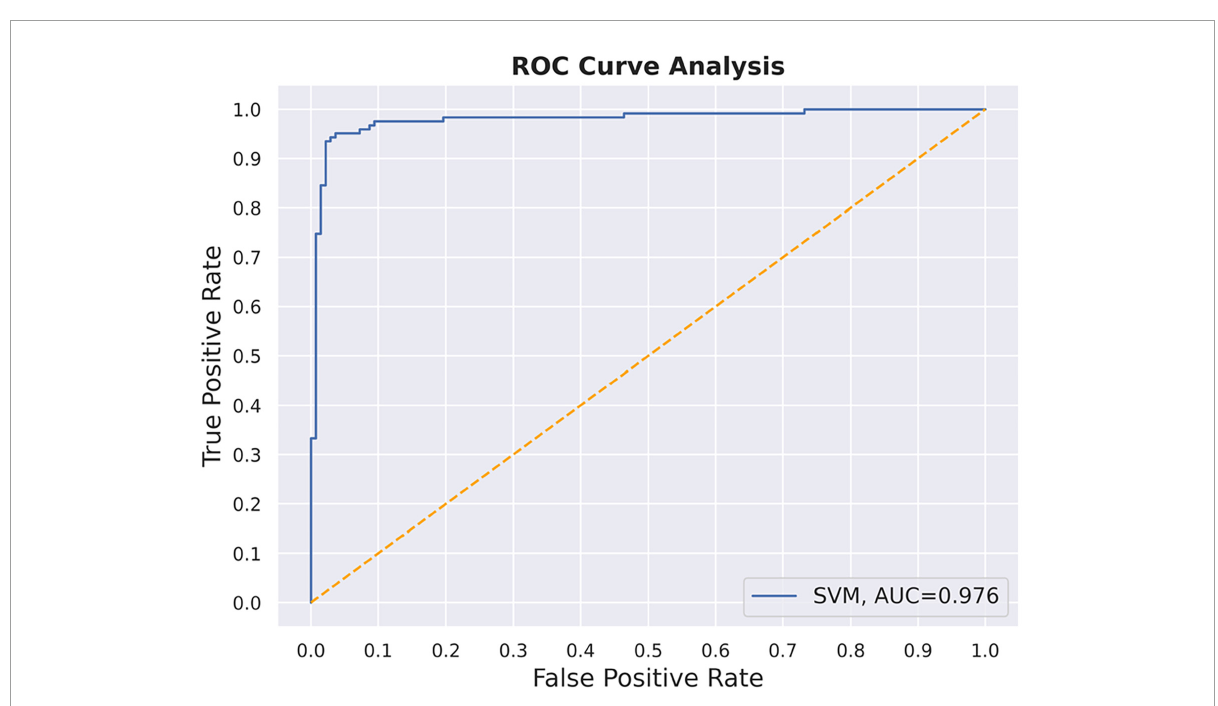
FIGURE5 The ROC curves of the nodal degree centrality in PCC in the support vector machine